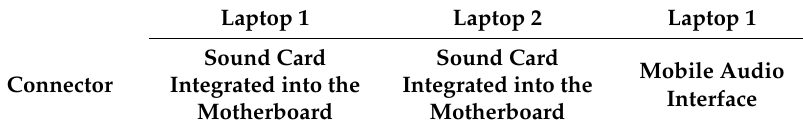
Table 2. Values of A-weighted maximum sound pressure level of the test signal reproduced by various headsets that were directly connected to Laptop 1 and Laptop 2, and to Laptop 1 through a mobile audio